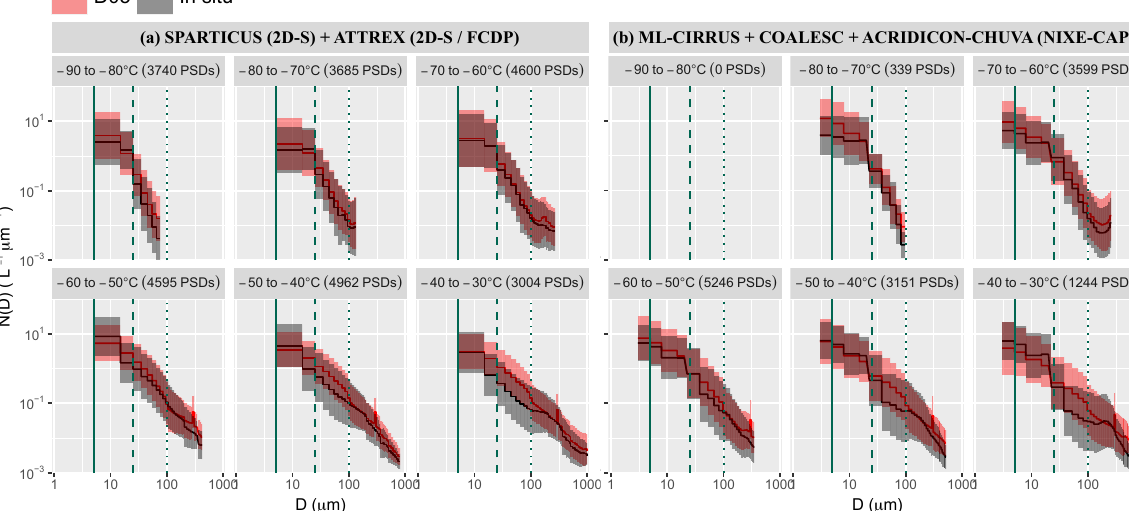
Figure 1. (a) Mean PSDs measured (black lines) during SPARTICUS and ATTREX, averaged per 10 ◦ C temperature bin (from − 90 to − 30 ◦ C). Black contours indicate one standard deviation around the mean. The mean and spread of one-to-one predictions by the D05 parameterization are similarly indicated in red. The total number of PSDs in each T c bin is indicated in the panel heading and the relative contributions from each campaign can be deduced from Fig. S1. Vertical plain, dashed and dotted green lines indicate D = 5, 25 and 100µm, respectively. The SPARTICUS data with T c < − 60 ◦ C are ignored here to avoid contaminating FCDP measurements with uncertainties arising from the first size bins of 2D-S. (b) Similar to (a) but for the ML-CIRRUS, COALESC and ACRIDICON-CHUVA